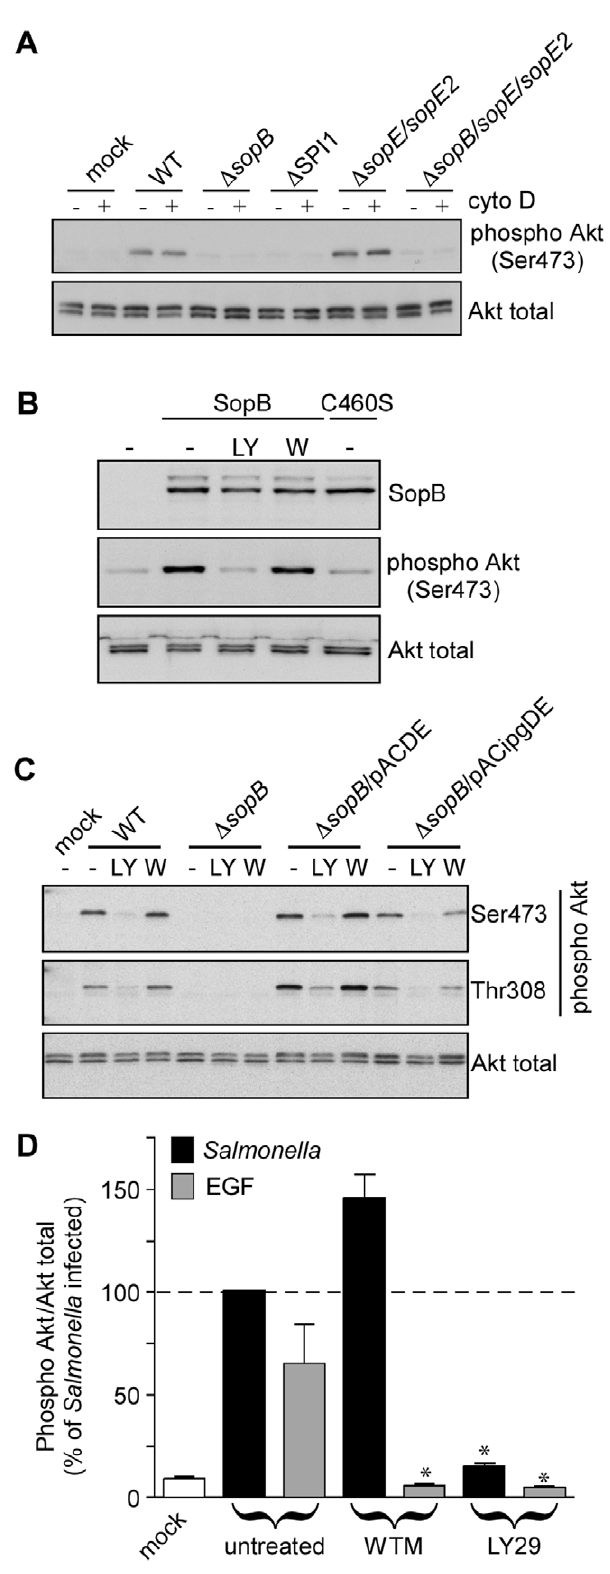
Figure 1. SopB–dependent Akt phosphorylation in epithelial cells is wortmannin insensitive. (A) HeLa cells were infected with Salmonella , either WT or the indicated mutants, for 20 min. Monolayers were then solubilized in sample buffer and processed for immunoblotting using rabbit polyclonal antibodies to detect phospho Akt (Ser473)